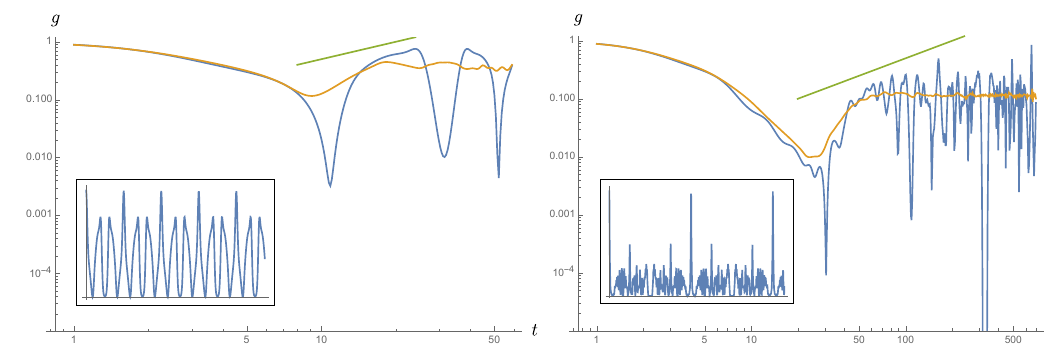
Figure 8 . Spectral form factor (blue) its progressive time-averaged version (yellow), and linear- in- t curve (green, for comparison with the ramp) for su (2) k with k = 3 (left) and k = 50 (right). The dip, ramp, and plateau emerge, but the ramp is superlinear. The insets display the linearly scaled